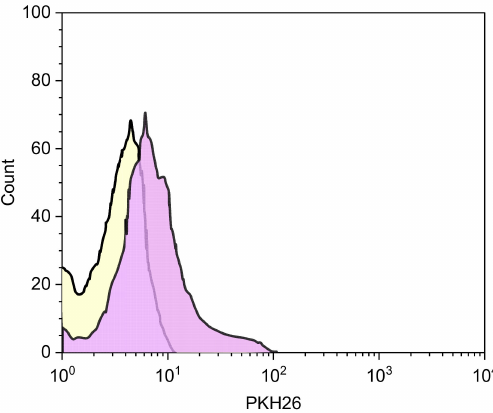
Figure 9. Cytofluorimetric analysis of CD44 negative ZR-75-1 cells incubated with CH/HY NPs for 24 h. Yellow histogram: negative control; violet histogram: ZR-75-1 cells incubated with labeled